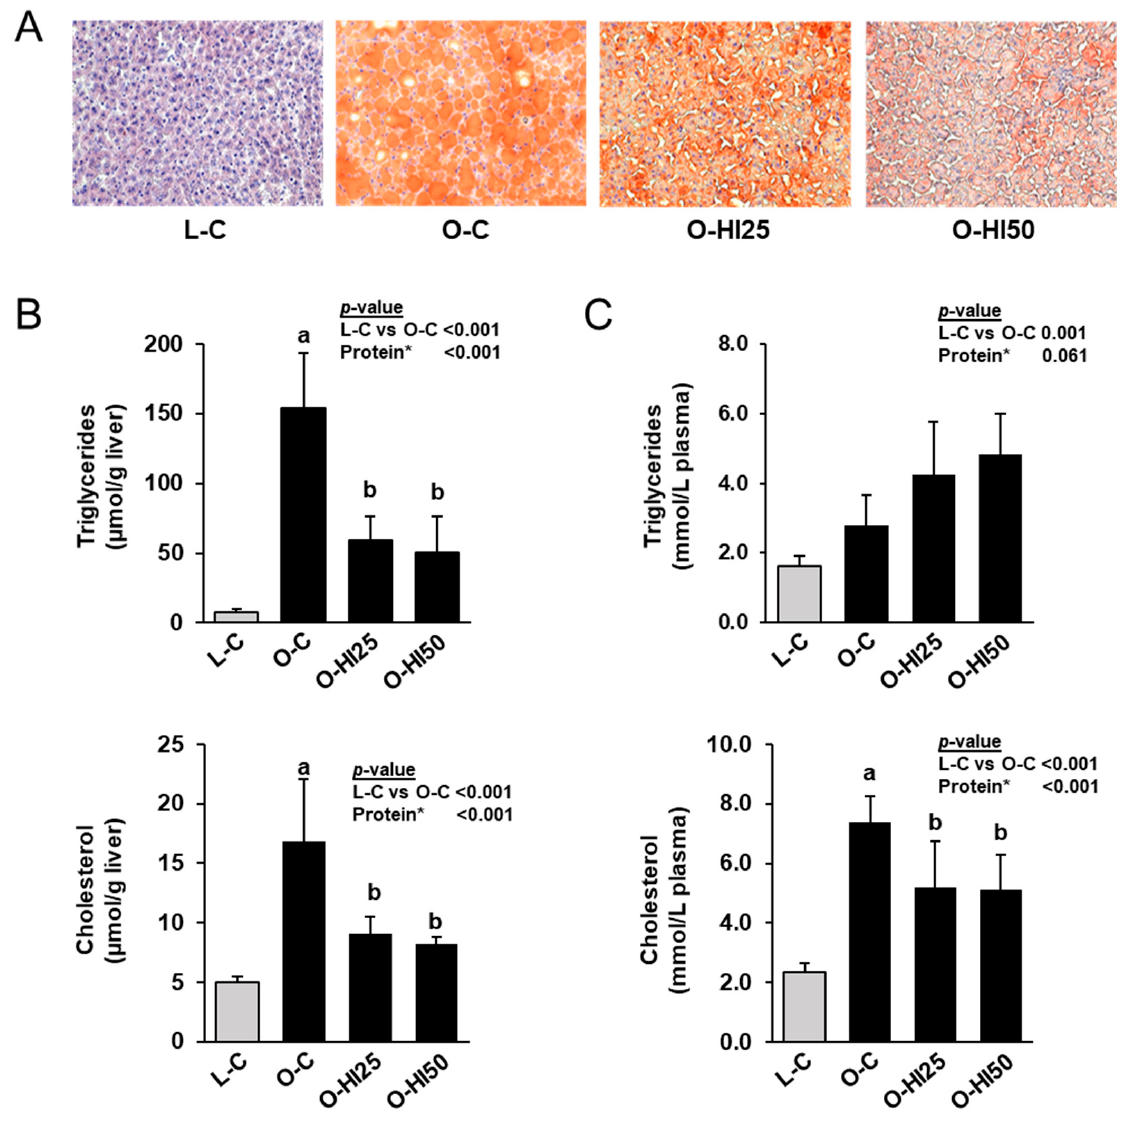
Figure 1. ORO-stained liver sections ( A ), triglyceride and cholesterol concentrations in liver ( B ) and plasma ( C ) of the rats. ( A ) Images are shown for one animal per group. ( B , C ) Bars represent means ± SD for n = 10 rats/group. * Effect of the protein source (C vs. HI25 vs. HI50) within the obese groups: a,b Bars without a common letter differ across the obese groups, p < 0.05.